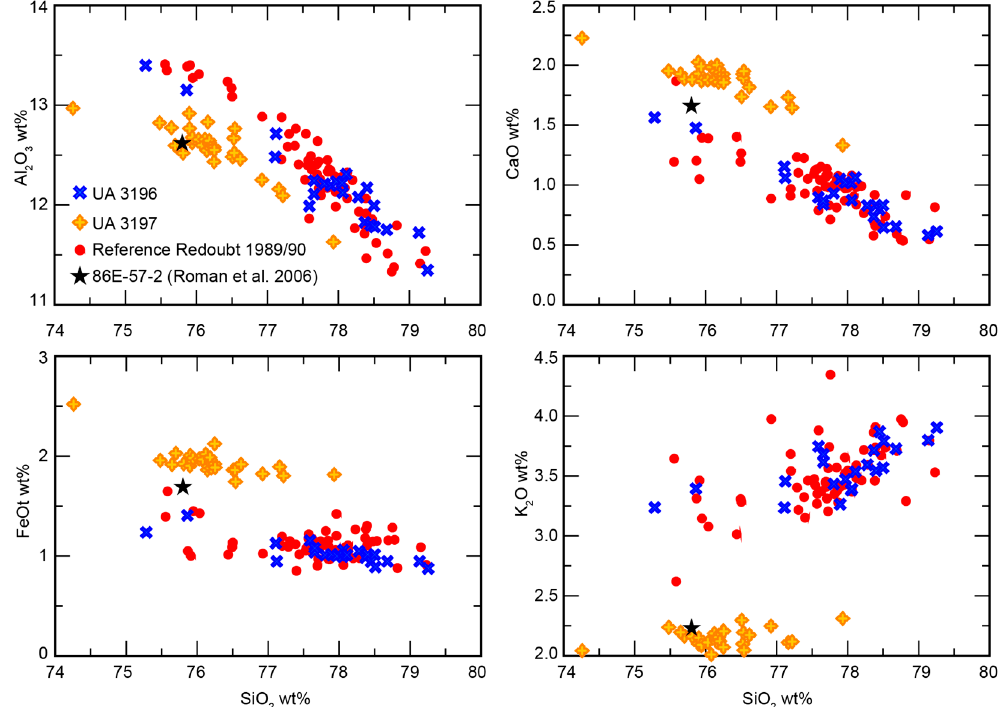
Figure 7. Plots of glass geochemistry of unknowns and reference data. UA 3196 plots with all elements with the reference data for the 1989/90 eruption of Redoubt [25]. Data from Roman et al. [27] of the Augustine eruption are the average of five analyses. Unfortunately, no standard deviation or standards are provided in the paper. However, the analyses for this population identified in the 1986 eruption are similar to UA 3197. All analyses, including standards, are available as supplementary materials (Table S1).